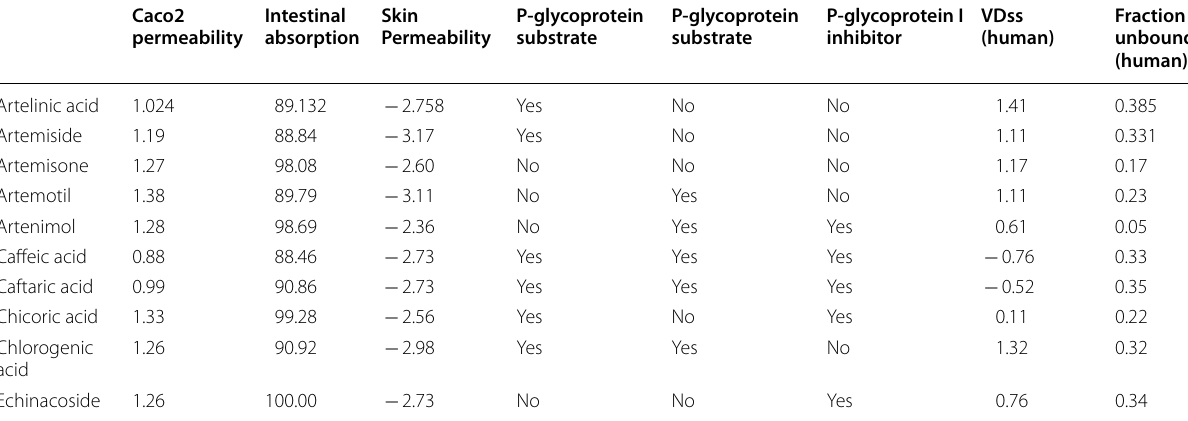
Table 5 ADMET properties of all studied